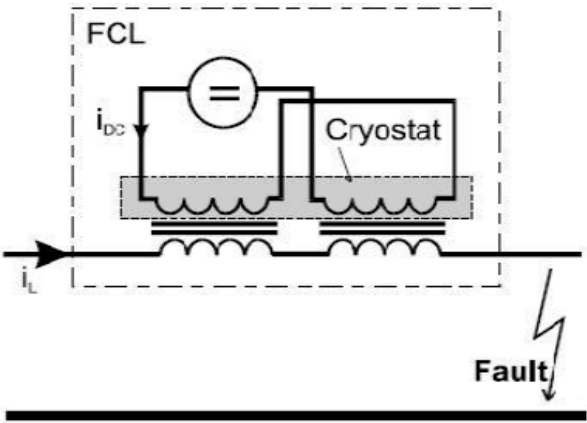
Figure 10. Diagram of saturated iron core type SCFCL.